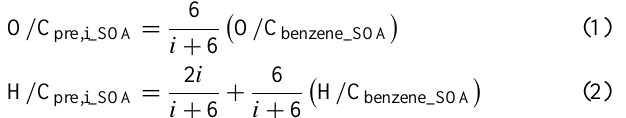
the monocyclic aromatic precursor, and O / C benzene_SOA and H / C benzene_SOA are the measured O / C and H / C in SOA from benzene photooxidation